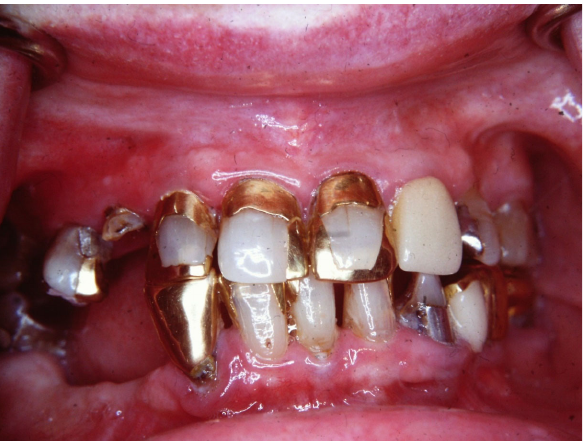
Figure 2. An 82-year-old female is referred for care by her daughter, as the dentist she used to go to has retired. She has a history of allergy to penicillin and sulfa drugs and has been diagnosed with hypertension and coronary artery disease. She also has arthritis in her hips and her hands. She is taking a calcium channel blocker, an ACE inhibitor, and a thiazide diuretic. For her arthritis, she is taking slow-release acetaminophen three times a day. Her chief complaint is that she is beginning to have difficulty eating some of the foods that require more chewing. Her oral examination shows extensive restorative work, which includes several gold inlays. Her periodontal examination revealed no probing depths beyond 3mm and mild bone loss. Although she has a lot of margins at risk, there was no evidence of recurrent caries or root caries. Her treatment will require maintenance care and the addition of a mandibular partial denture. Although the maxillary right lateral incisor is broken down, it was asymptomatic, has no caries or periapical pathology, and she was not concerned with the esthetic correction of this tooth. This patient represents a person who has several important risk factors but does not show any signs of rapid oral health